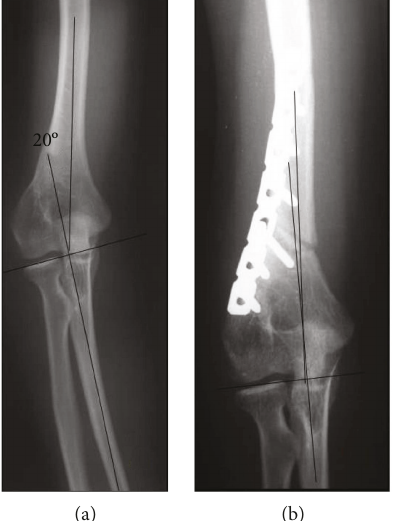
Figure 2: Case 1. (a) Preoperative AP radiograph. (b) Postoperative AP